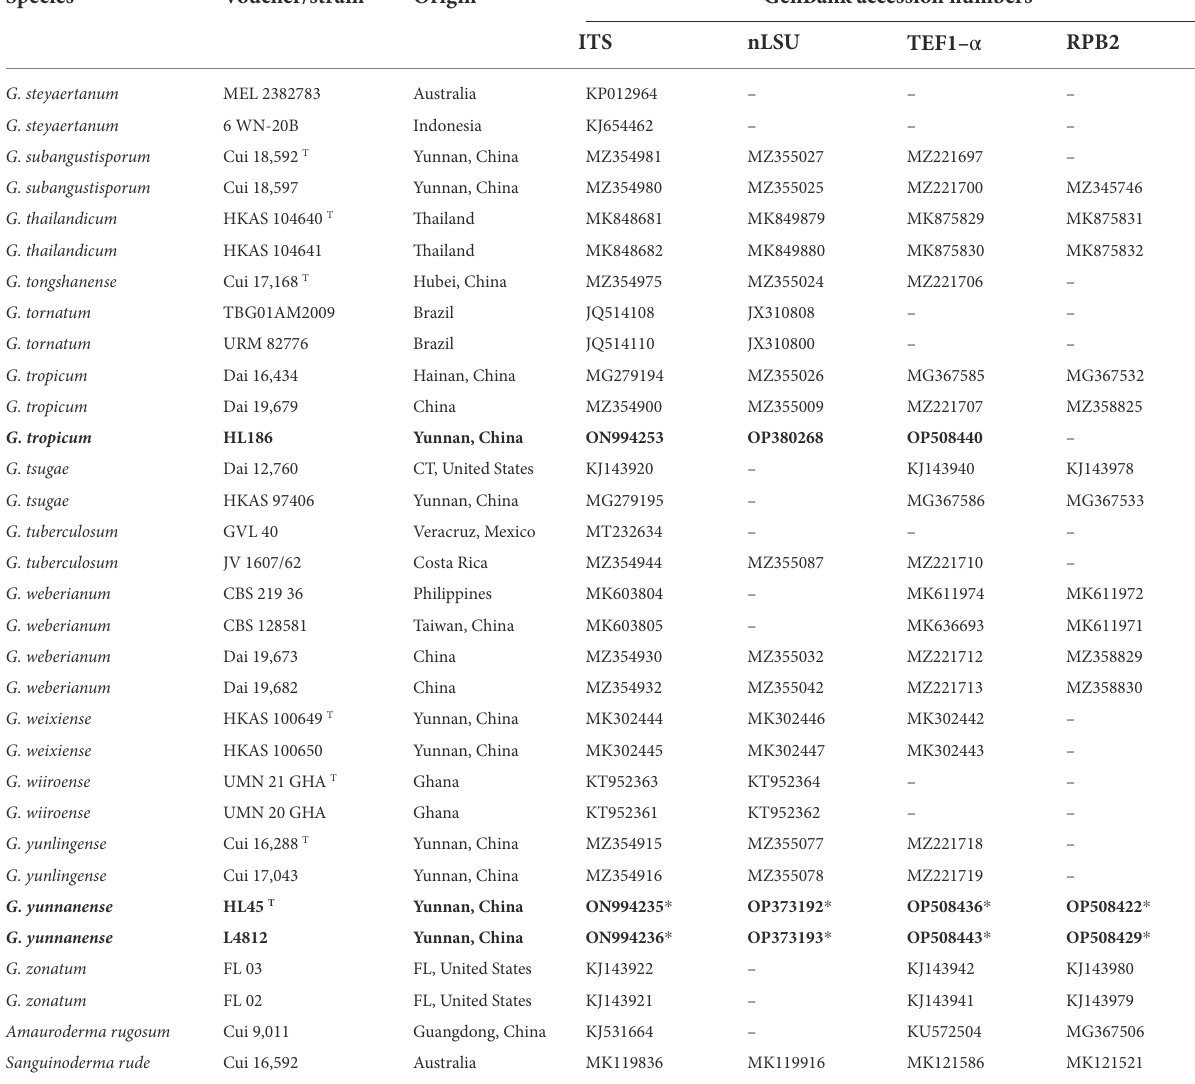
of the maximum likelihood analysis and Bayesian analysis is similar. The RAxML analysis of the combined dataset yielded the best scoring tree with a final ML likelihood value of − 33599.741722 (Figure 3). The matrix had 1,087 distinct alignment patterns, with 36.13% undetermined characters or gaps. Estimated base frequencies were as follows: A = 0.223924, C = 0.253042, G = 0.274308, T = 0.248726; substitution rates AC = 1.353439, AG = 6.944619, AT = 1.408316, CG = 1.653377, CT = 9.659772, GT = 1.000000, α = 0.194286, Tree-Length: 1.880697. Best model for the ITS + nLSU + TEF1- α + RPB2 dataset estimated and applied in the Bayesian analysis were HKY + I + G for ITS [Lset nst = 2, rates = invgamma; Prset statefreqpr = Dirichlet (1,1,1,1)] and GTR + I + G for nrLSU, TEF1- α and RPB2 [Lset nst = 6, rates = invgamma; Prset statefreqpr = Dirichlet (1,1,1,1)]. ML and BI analyses generated nearly identical tree topologies with